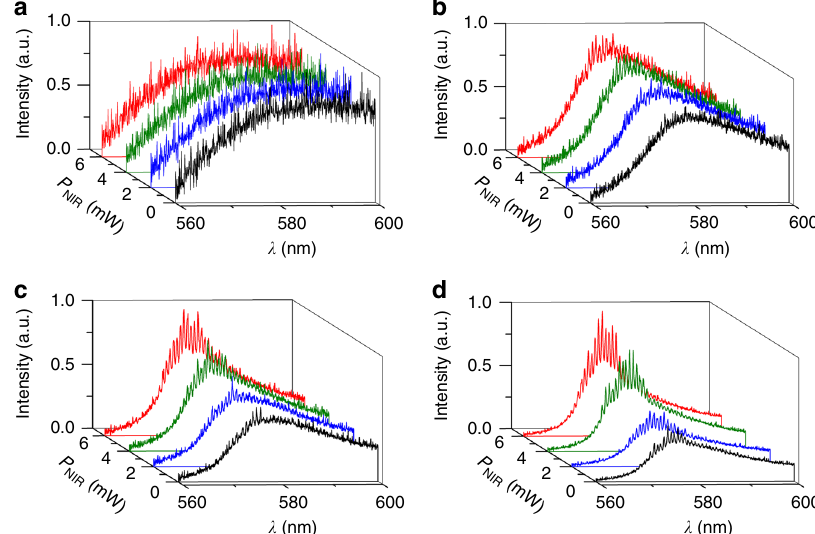
Fig. 2 Emission spectra in the presence of nematicon. Spectral emission normalized to unity for nematicons of various powers (colors) co-launched with the ordinary-wave pump, averaged over 200 gated acquisitions. a Pump pulse energy E = 0.40 μ J. b E = 0.48 μ J. c E = 0.51 μ J. d E = 0.55 μ